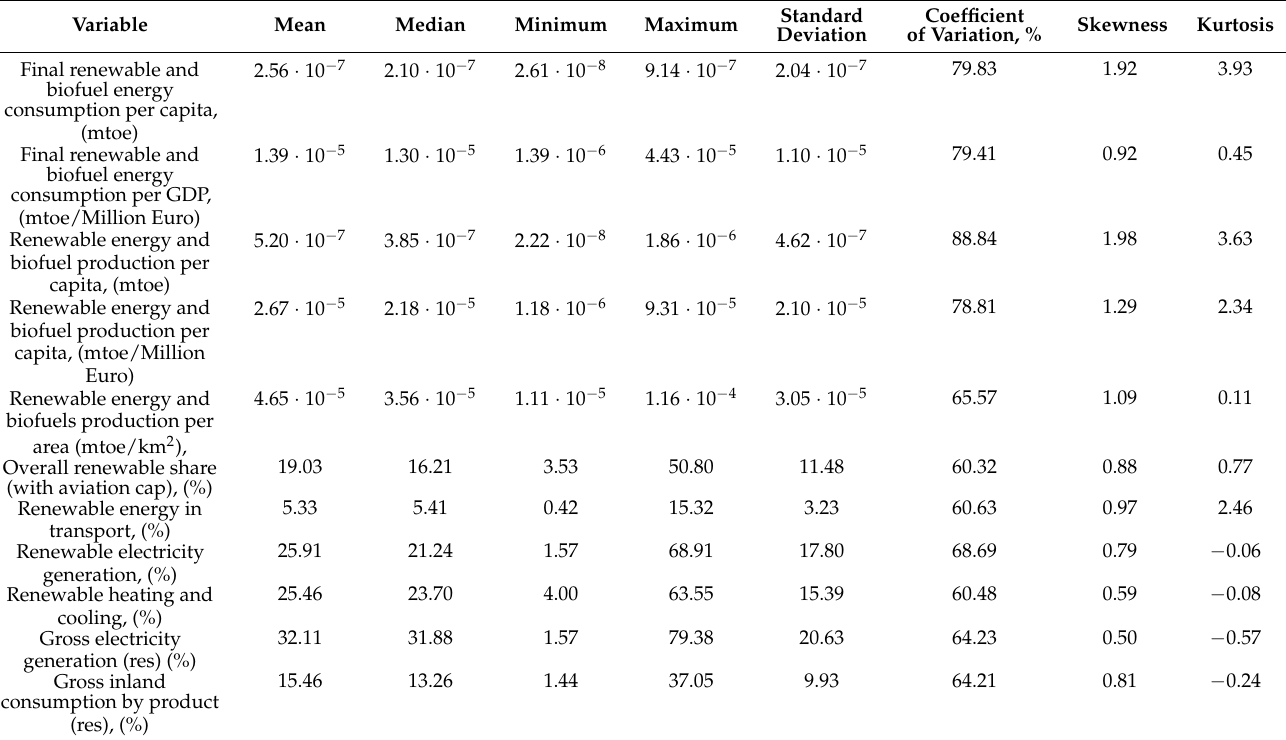
Table 3. Selected statistical indicator parameters describing RES development in the EU countries in